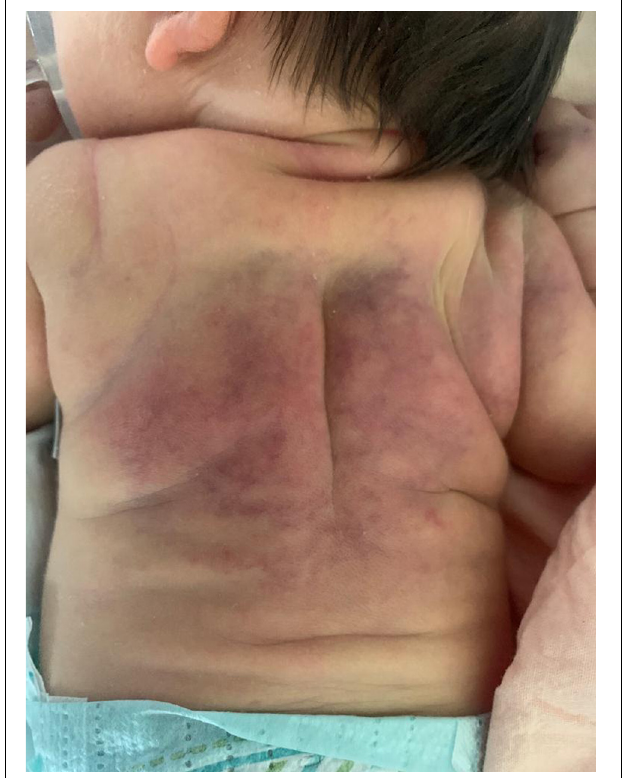
FIGURE 1 | Skin lesion on the back and the